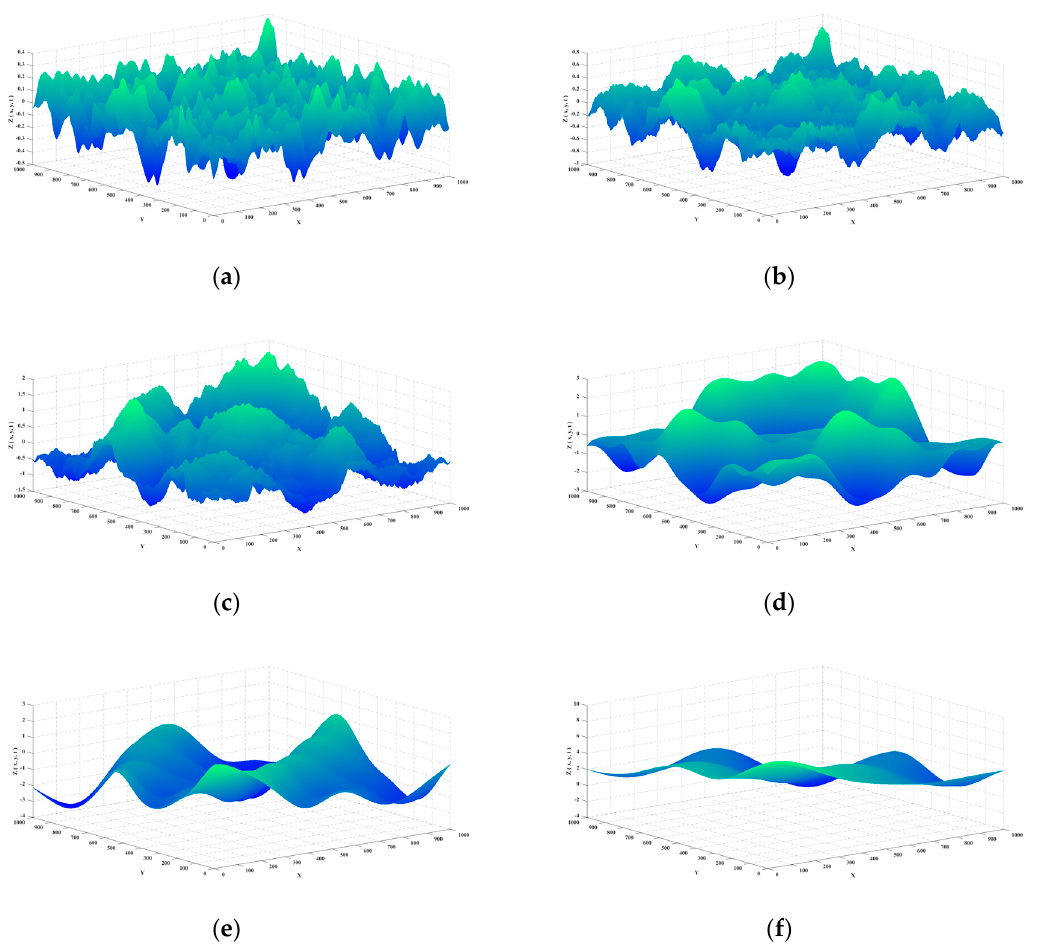
Figure 2. 1000 × 1000 mesh of the waves at typical wind speeds. ( a ) the wind speed is 5 m/s; ( b ) the wind speed is 7 m/s; ( c ) the wind speed is 9 m/s; ( d ) the wind speed is 13 m/s; ( e ) the wind speed is 16 m/s; ( f ) the wind speed is 20 m/s.